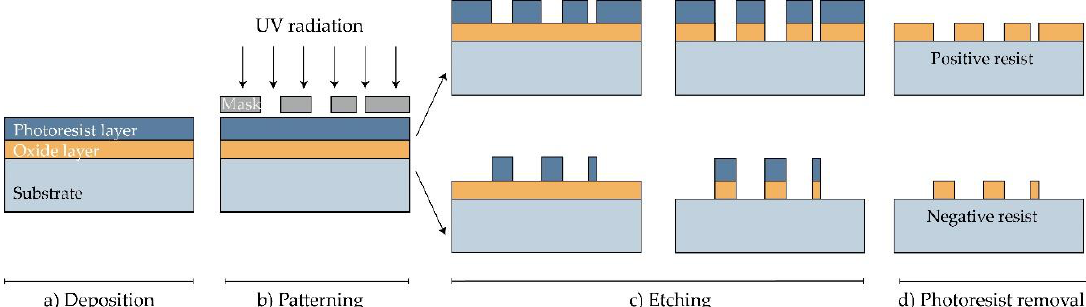
Figure 3. Manufacturing of MNs using photolithography [117]. ( a ) Deposition: As a substrate, Si wafer is exposed to steam or humidified to produce the wafer with an oxide coating. Then, the photoresistive material is spin-coated onto a substrate. ( b ) Patterning: Mask guided UV radiation is exposed to the photoresistive material. ( c ) Etching: soluble resist material is removed and SiO 2 film etched. ( d ) Photoresist removal: in this step, the photoresist layer is removed.